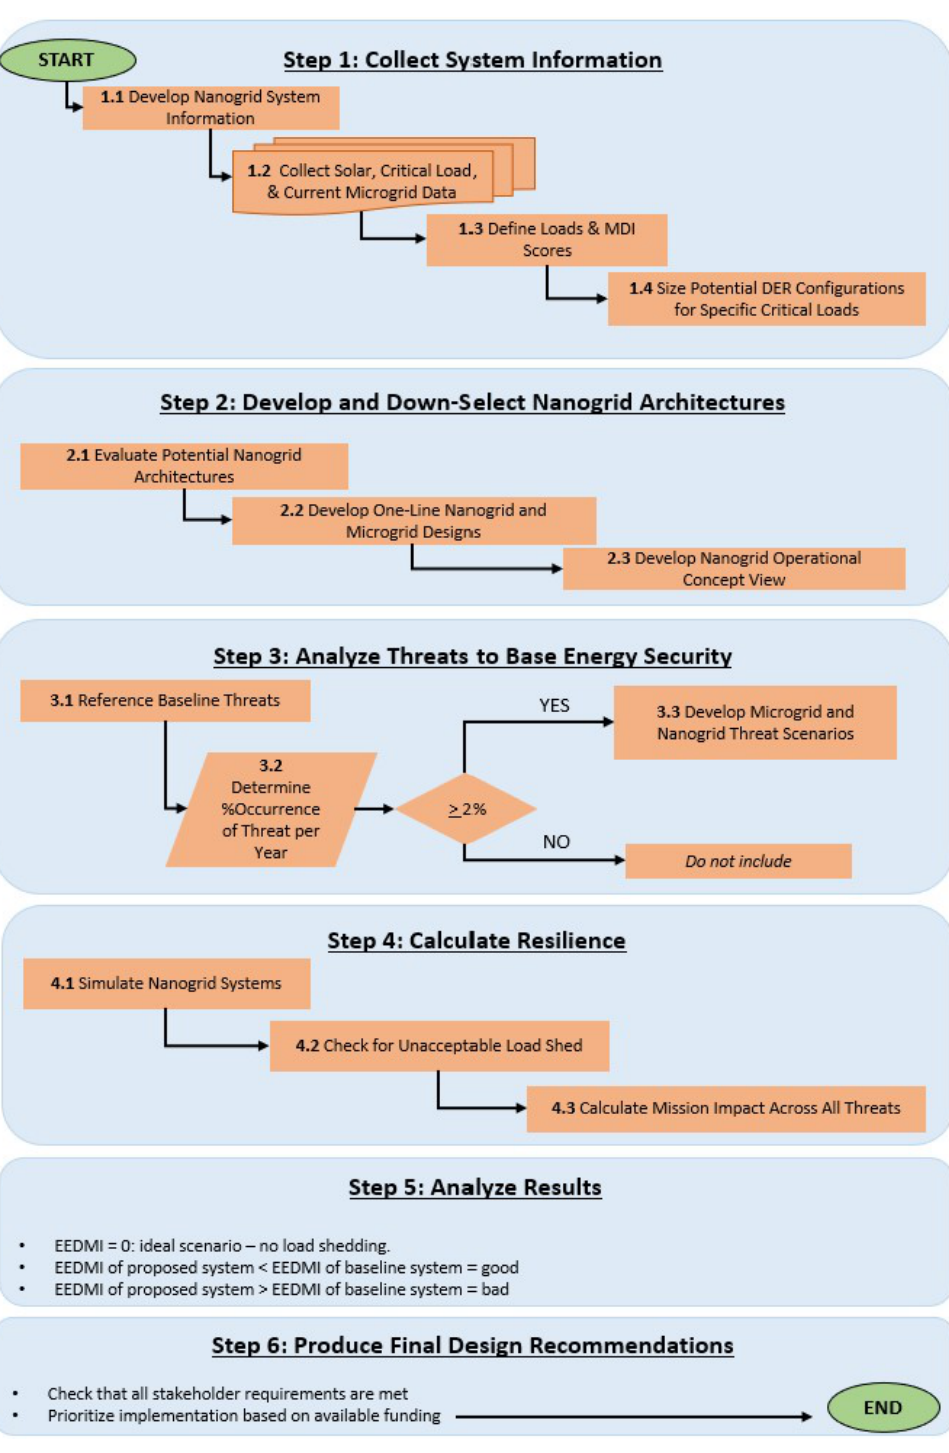
Figure 1. Overview of Methodology. This methodology is created for base energy managers to follow, starting with the collection of system information and ending with final design